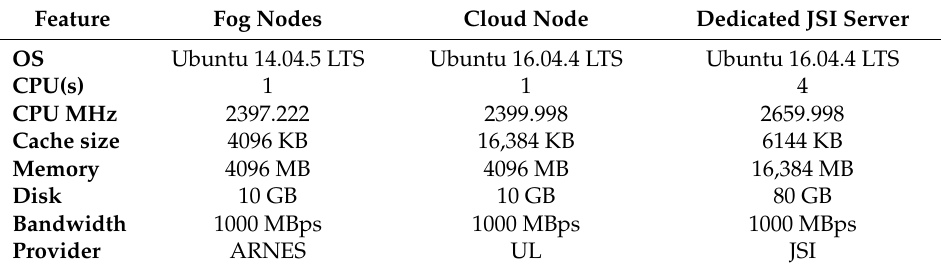
Table 3. Characteristics of infrastructures applied in our